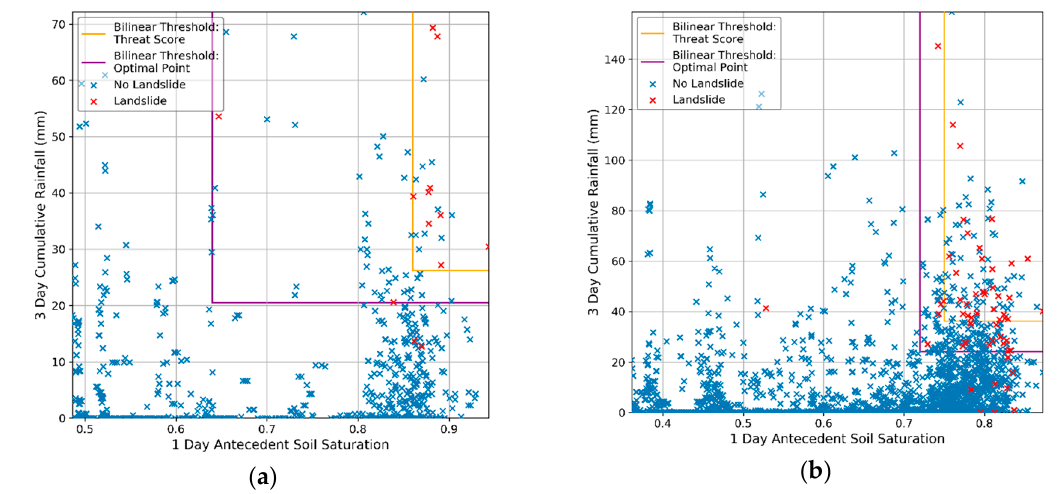
Figure 11. Dual hydro-meteorological threshold plots optimized with threat score and optimal point statistics for ( a ) Seattle-Everett railway and ( b ) City of Portland.